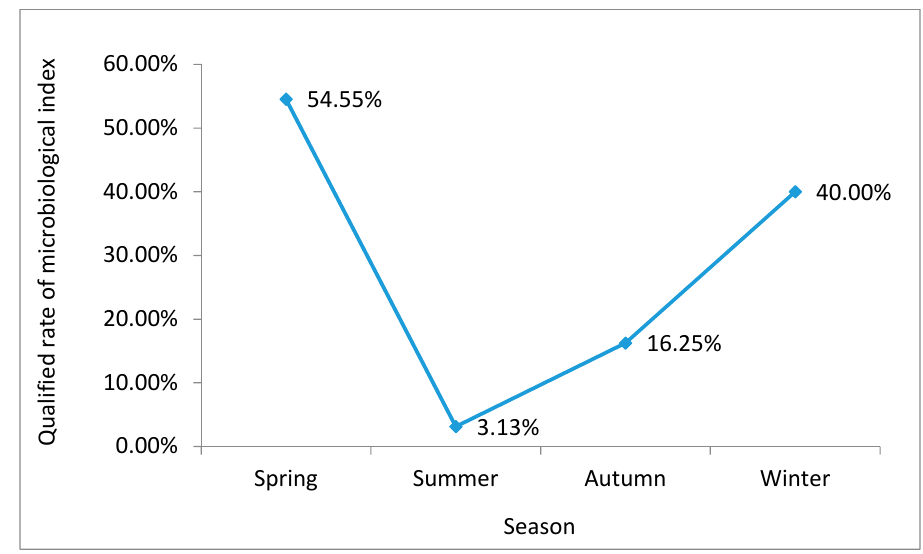
Figure 3. Annual changes in the qualified microbiological index rate.